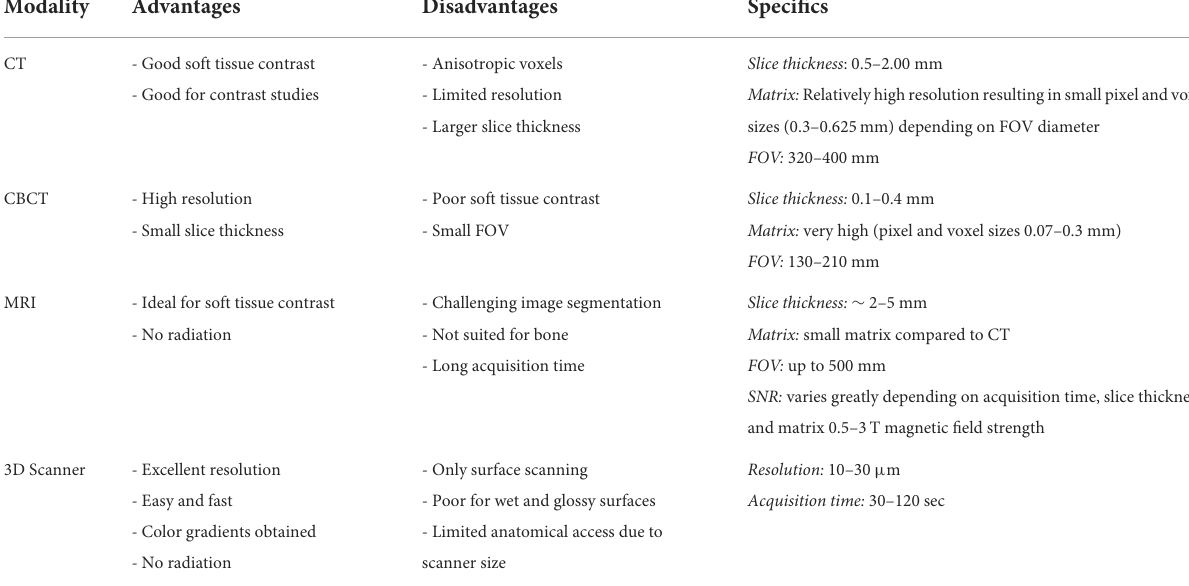
TABLE 1 Imaging modalities